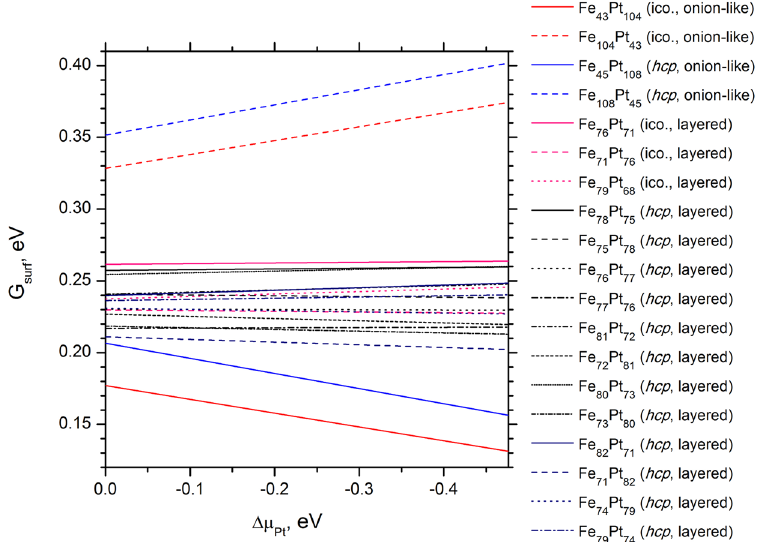
Figure 5. Thermodynamic stability diagram as a function of Pt chemical potential built for all FePt NPs under study. Diagram takes into account precipitation conditions for both Fe and Pt